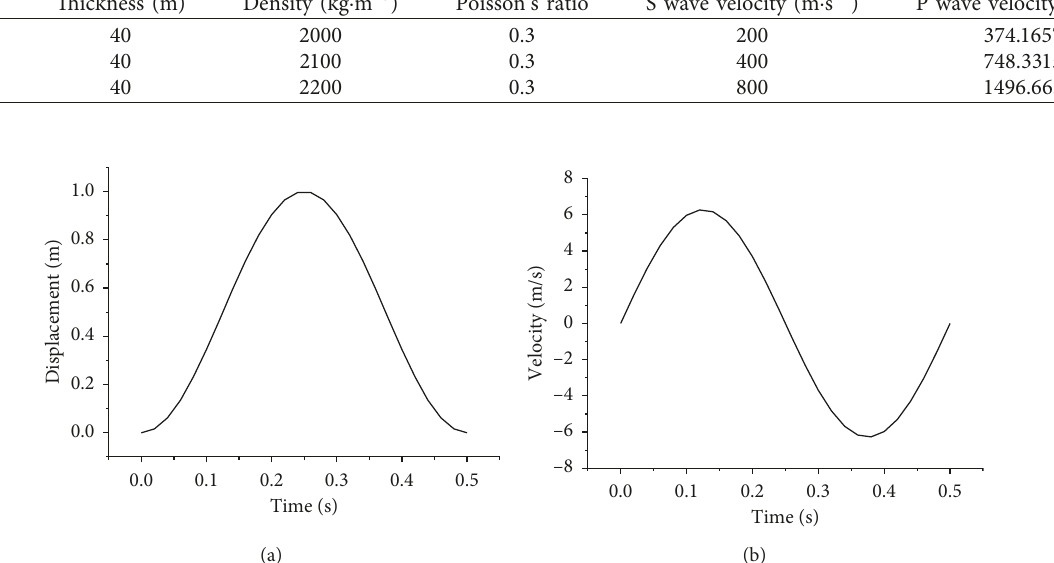
Figure 3: Displacement diagram and velocity diagram of pulse wave. (a) Displacement diagram of pulse wave; (b) velocity diagram of pulse